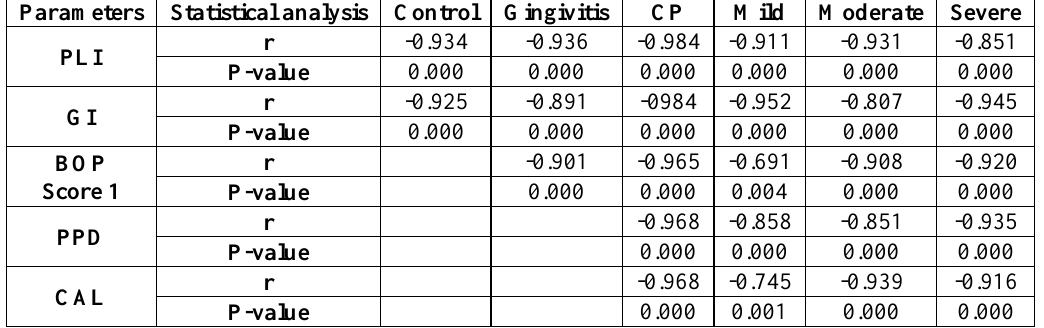
Table 6: Correlations between the levels of salivary FR with the clinical periodontal parameters of groups and